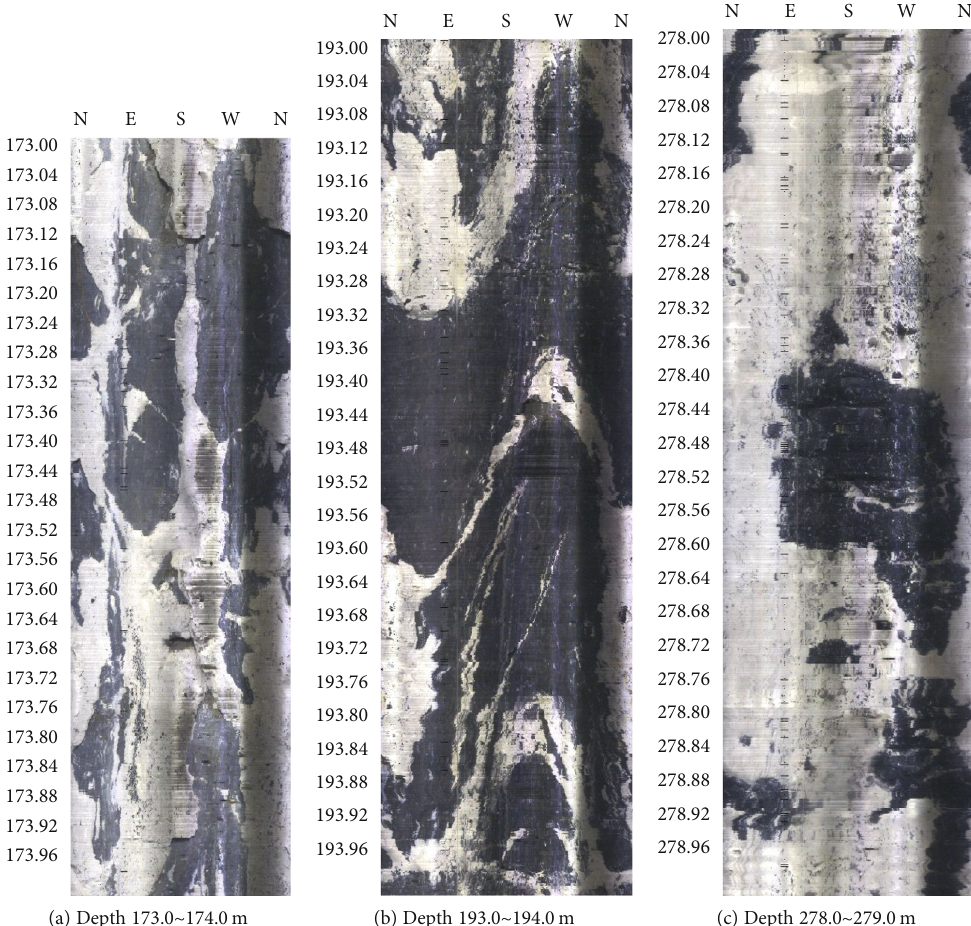
Figure 9: Filling situation of rock formation cracks below 170m in No. II inspection